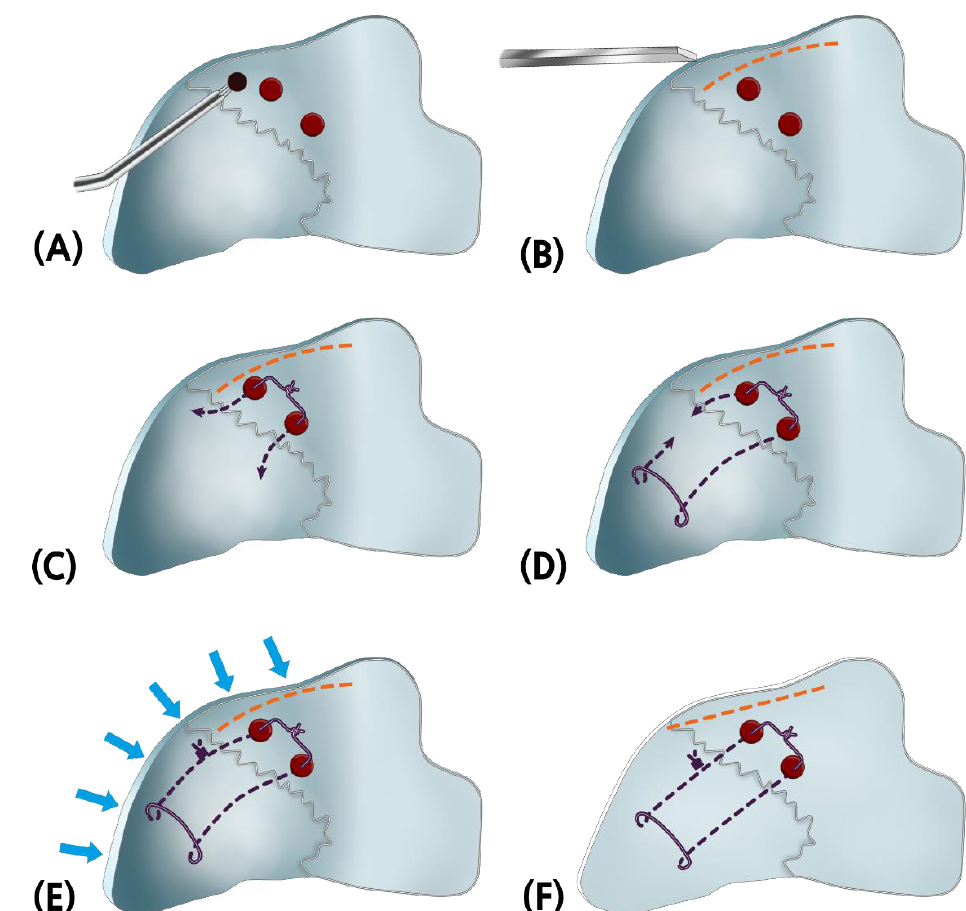
Figure 3. Illustration of a modified mattress suture technique of the bony-cartilaginous junction below the keystone area. ( A ) Vertical holes are made into the perpendicular plate of the ethmoid bone (PPE) using a 2.5-mm drill. ( B ) Using a 2-mm osteotome, a greenstick fracture is performed on the dorsal part rather than the hole in the PPE. ( C ) Vicryl suture with double-arm needles is passed through the two holes, from the concave to the convex sides of the nasal cavity. ( D ) The lower needle is brought down, parallel to the nasal dorsum, and then passed through the septal cartilage. ( E ) From the convex side of the nasal cavity, the suture is tied up while pushing the cartilage and the bone. ( F ) The nasal septum is now straightened, starting below fracture line.